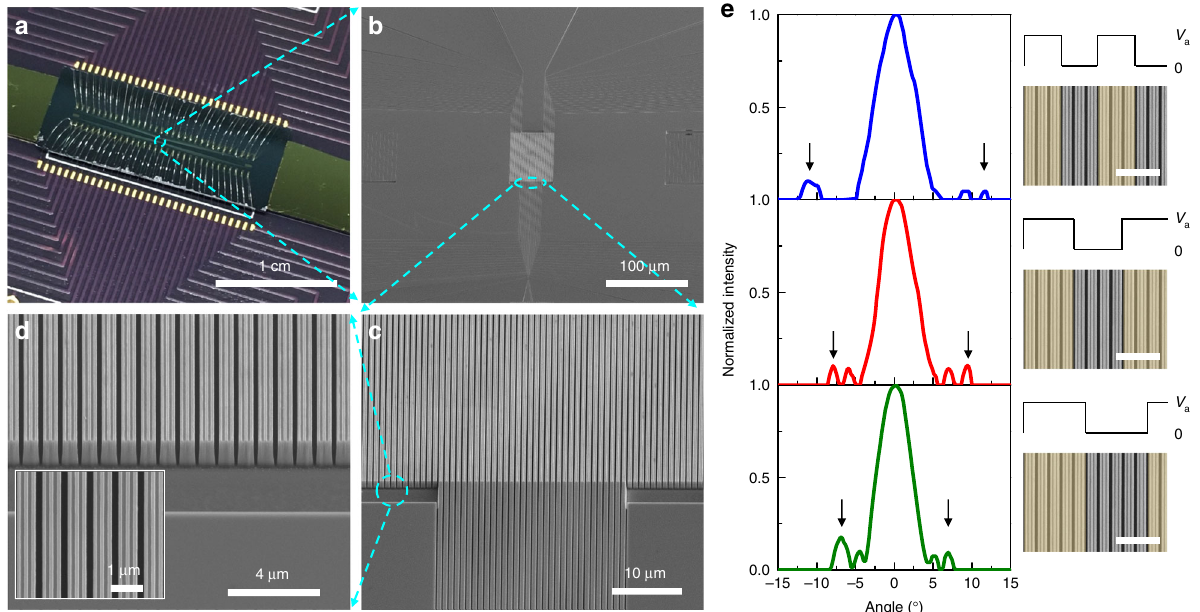
Fig. 5 Tunable beam steering with MQW-based all-dielectric metasurface. a Photographic image of the fabricated gate-tunable metasurface for the demonstration of dynamic beam steering. The metasurface sample is mounted on a voltage-deriving PCB, which has 64 contact pads for individually applying bias on each metasurface unit element. b – d Scanning electron microscopy images of the gate-tunable metasurface. To electrically isolate every unit structure, portions of the sample are fully etched. Inset in ( d ) shows the top view of the fabricated metasurface. e Measured results of dynamic beam steering by electrically changing the periodicity of metasurface. Black arrows indicate the position of the fi rst diffraction order in each case. Right column illustrates how the spatial arrangement of electrical bias changes the periodicity of metasurface. The incident wavelength is fi xed at 917 nm. Scale bars: 3 μ